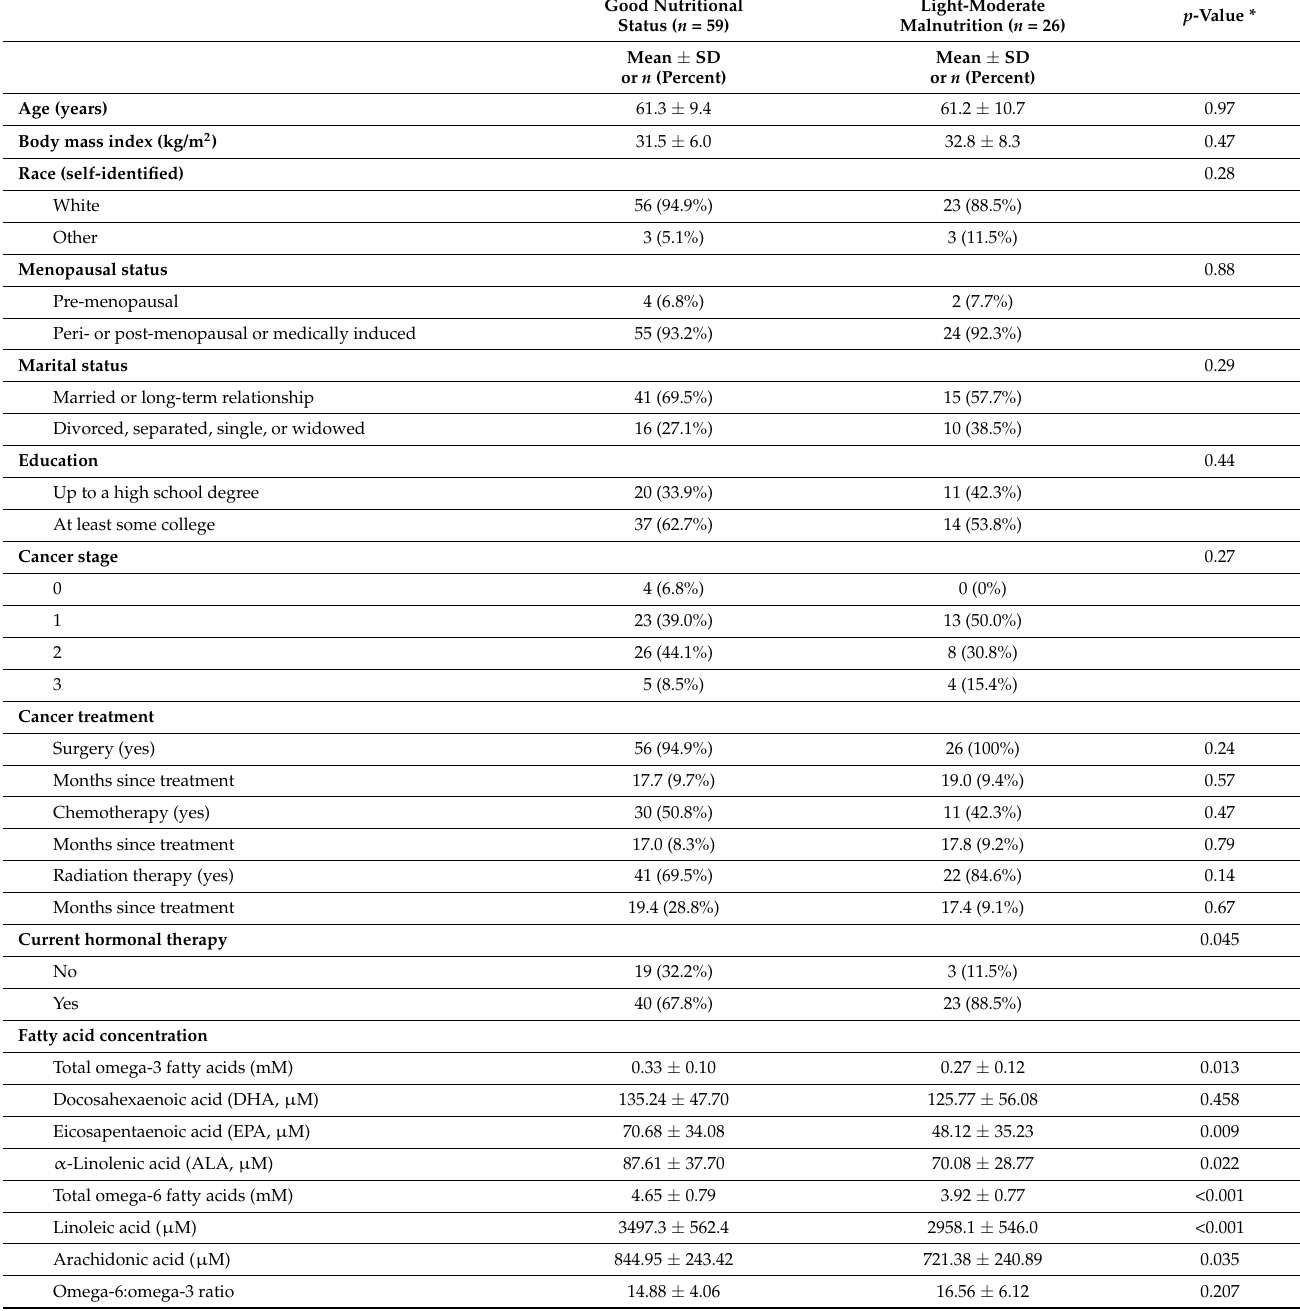
Table 1. Demographics and clinical characteristics ( n = 85) at